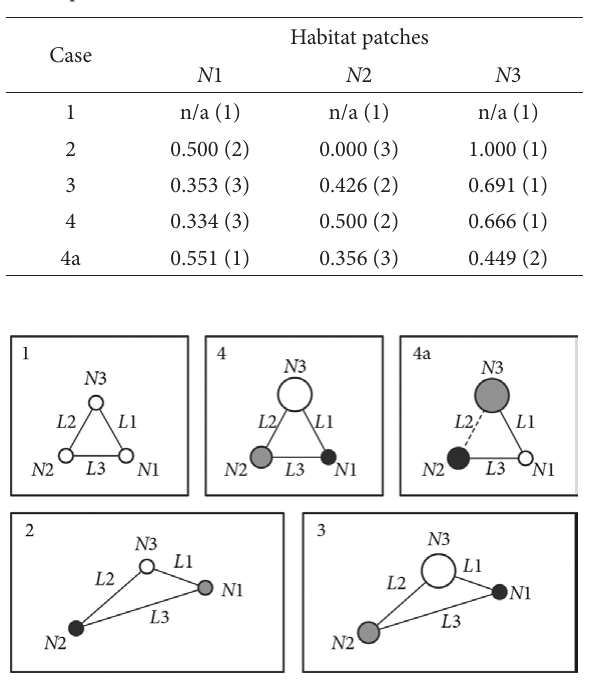
Fig. 3. Different cases illustrating three types of habitat patch ranking according